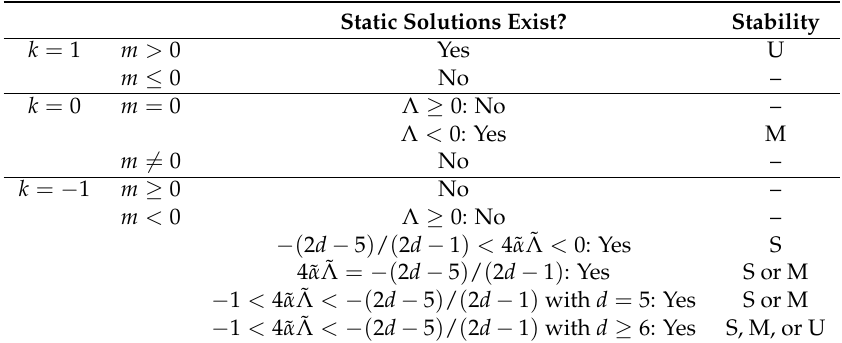
Table 6. The existence and stability of Z 2 symmetric static thin-shell wormholes made of pure